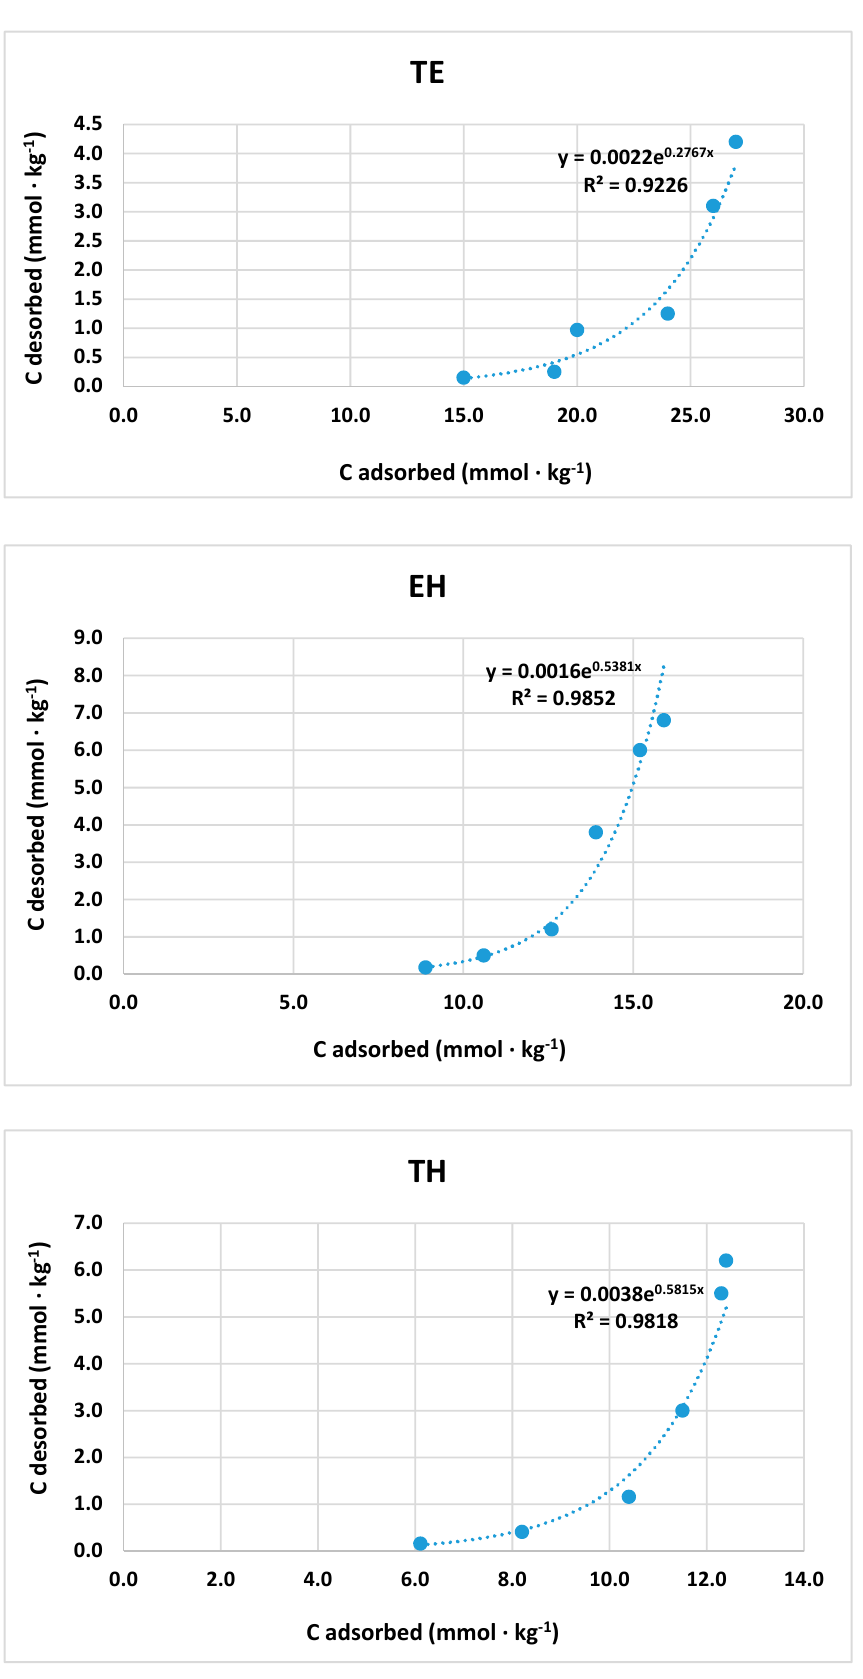
Figure2. Figure 2. The relationship between tungstate adsorption and desorption in the three soils TE, EH and TH.